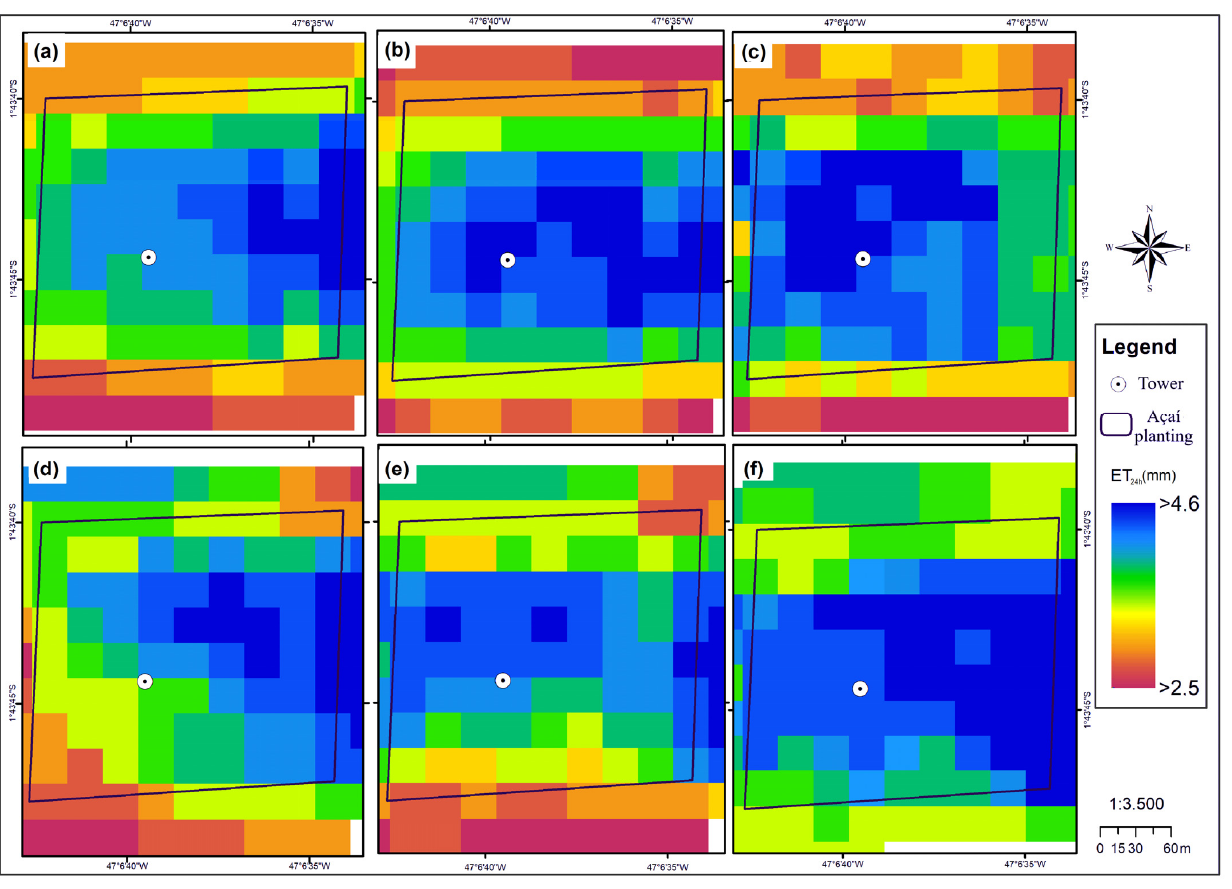
Figure 11. Spatial variability in evapotranspiration estimation in açaí planting area on the analyzed days: ( a ) 20 November 2017(DJ 324); ( b ) 22 December 2017 (DOY 356); ( c ) 31 May 2018 (DOY 151); ( d ) 7 June 2018 (DOY 158); ( e ) 26 June 2019 (DOY 177); ( f ) 29 August 2019 (DOY 241). 3.99 mm day − 1 was observed, with a minimum average of 3.11 mm day − 1 on 26 June 2019 (Figure 11e), and a maximum of 4.59 mm day − 1 on 29 August 2019 (Figure 11f). The lowest value observed among the images was 2.70 mm day − 1 on 26 June 2019; this value is below the empirical water slide used in the entire area by the owner (3.28 mm day − 1 ). The maxi- mum value was 4.89 on 29 August 2019 (Figure 11f).